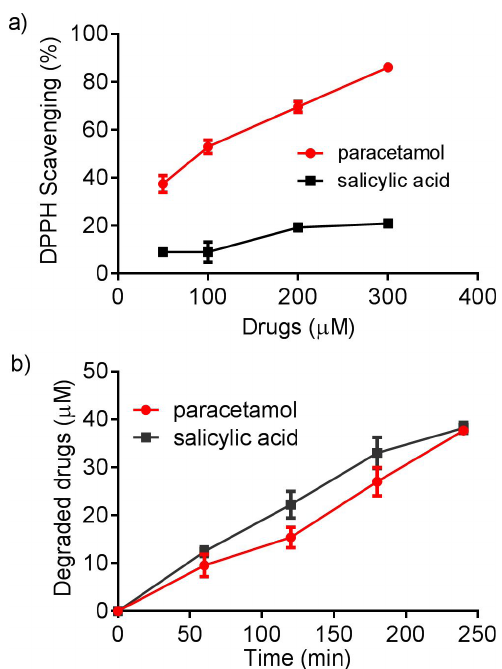
Figure 2. Oxidability of the salicylic acid and paracetamol evaluated by (a) DPPH scavenging and (b) reactivity with HO• generated by H O /hν in the absence of nanostructured semiconductors. The 2 2 results (c) are expressed as means and SD of three